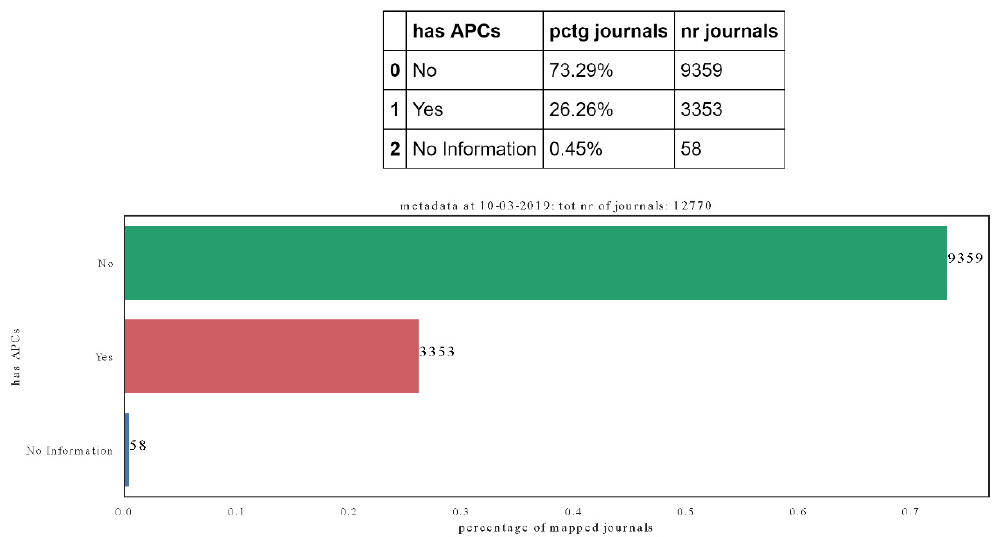
Figure 3. Proportion of journals indexed in the DOAJ (Directory of Open Access Journals) that charge or do not charge APCs (article-processing charges). For a small portion, the information is not available. All code and data needed to reproduce these figures are on Zenodo: http://doi.org/10.5281/zenodo.2647404.